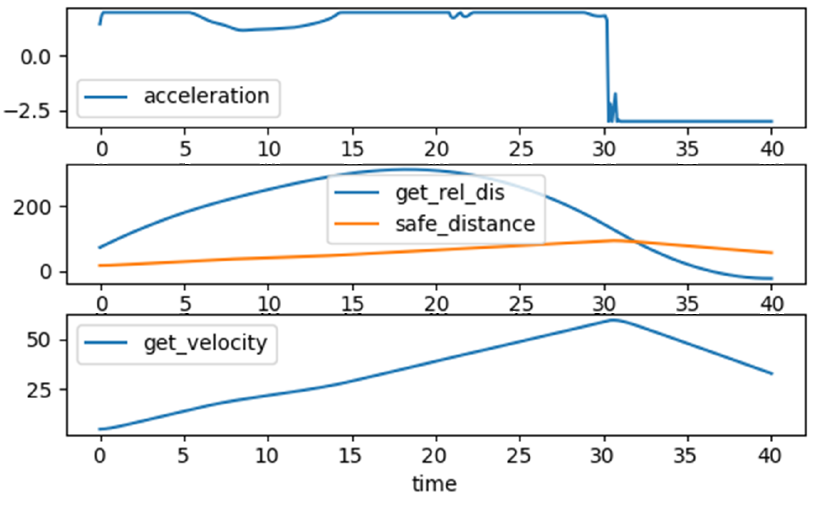
Figure 9. Result of the FI with the trained agent on